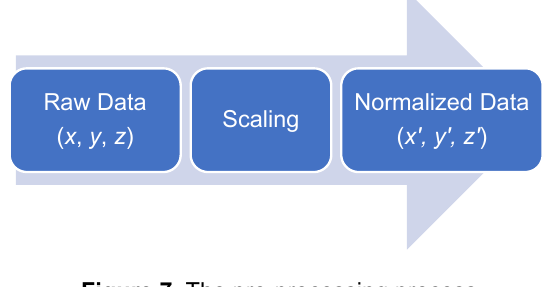
Figure 7. The pre-processing process